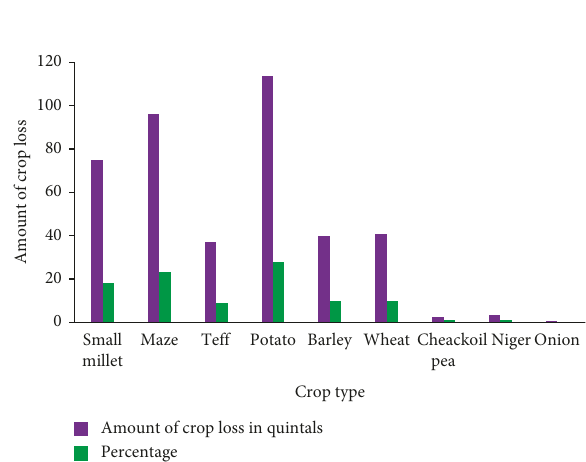
Figure 3: The amount of crop loss in quintals per three years of the study